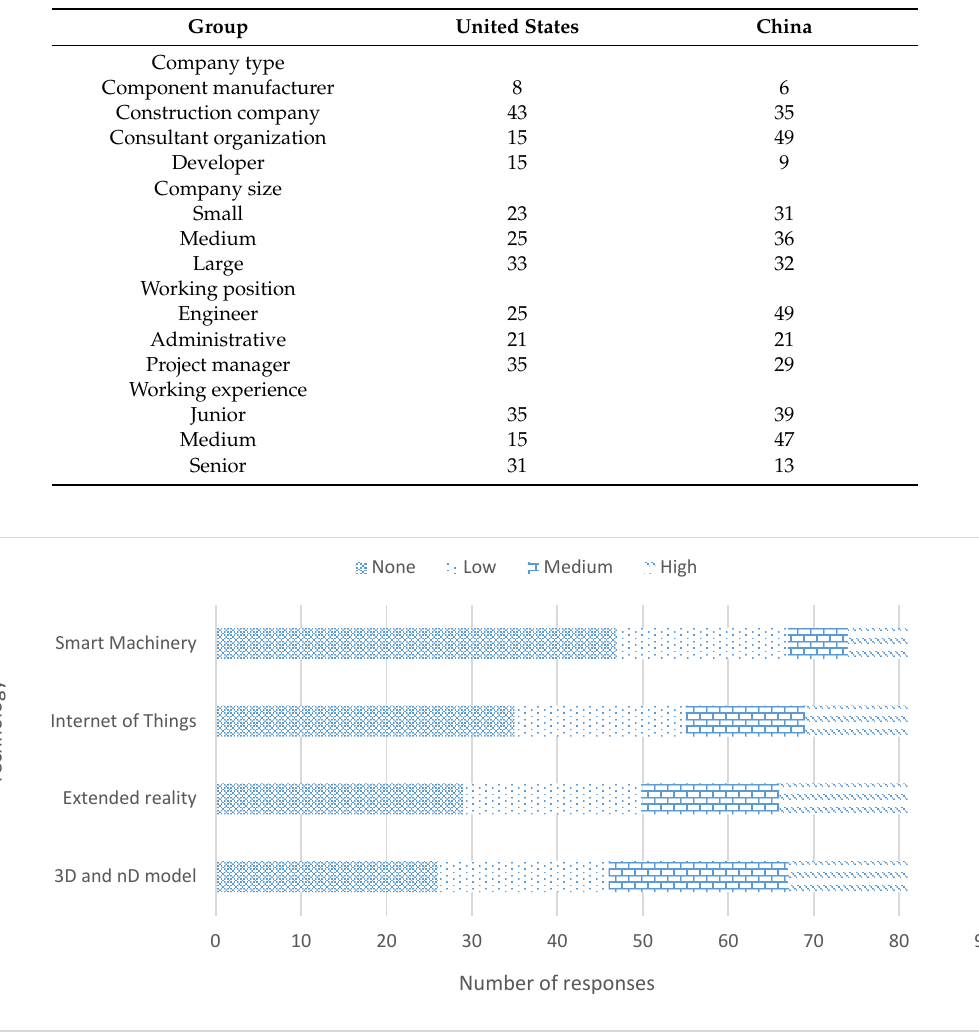
Figure 1. Average technology utilization levels of the United States practitioners.